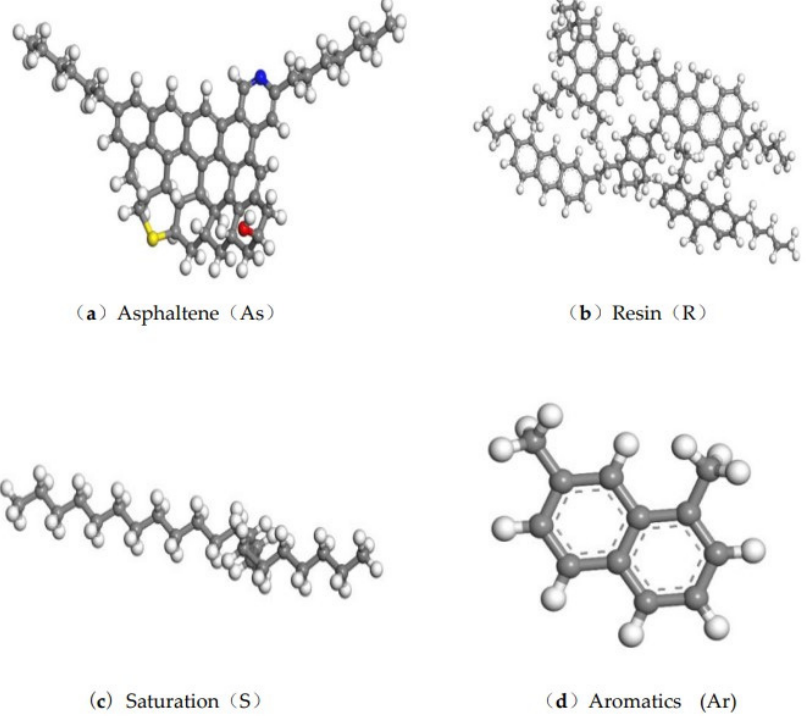
Figure 1. Four-component molecular model of asphalt (C atoms in gray, H atoms in white, N atom in blue, O atom in red, S atom in yellow) ( a ) Asphaltene; ( b ) Resin; ( c ) Saturation; ( d ) Aromatics.